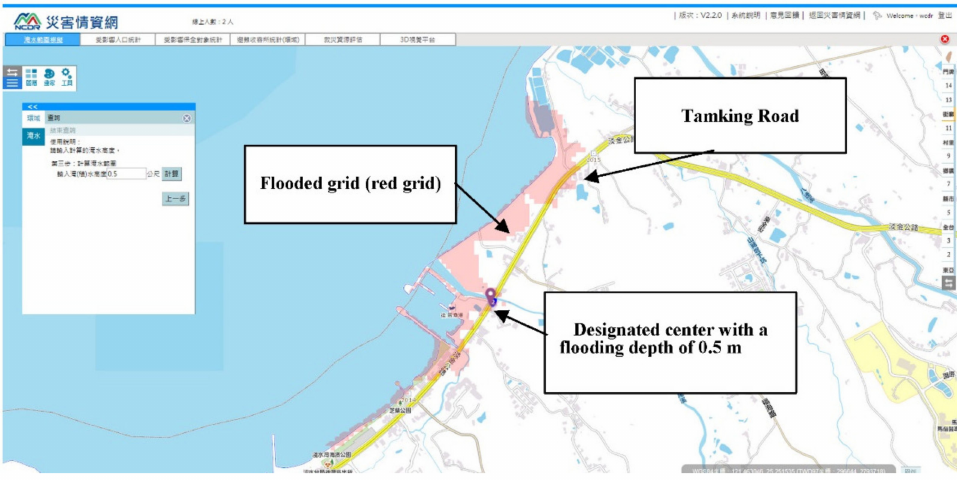
Figure 12. Flooded area of Sanzhi